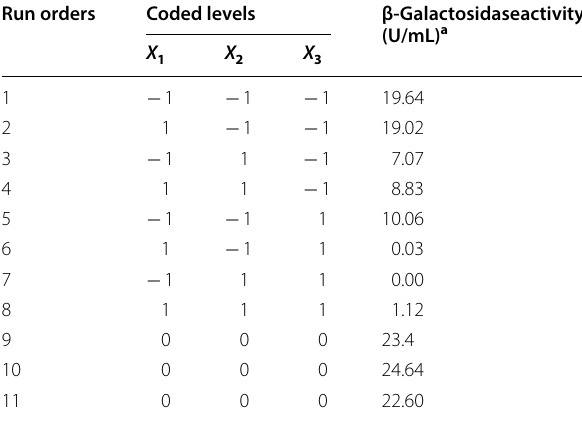
(Table 2). The results showed a maximal β-galactosidase activity (24.64 U/mL) at the central point of the 2 3 full factorial design. The best conditions involving the soy- bean residue as a substrate were found at 120 rpm, 30 °C, and pH 7.0.